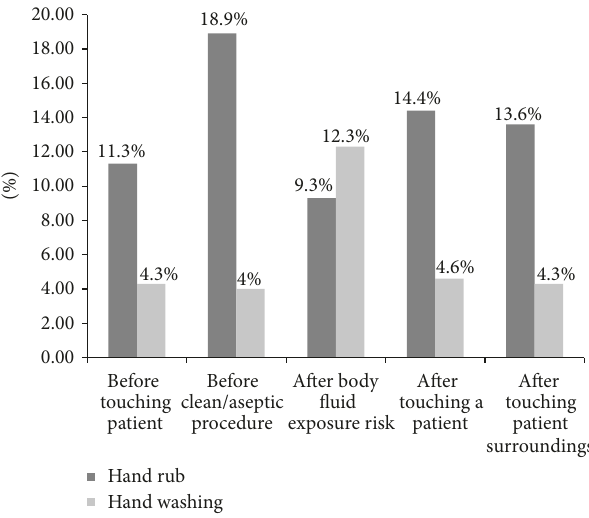
Figure 1: Method of hand hygiene of nurses in governmental hospitals of Harari Regional State, Eastern Ethiopia,